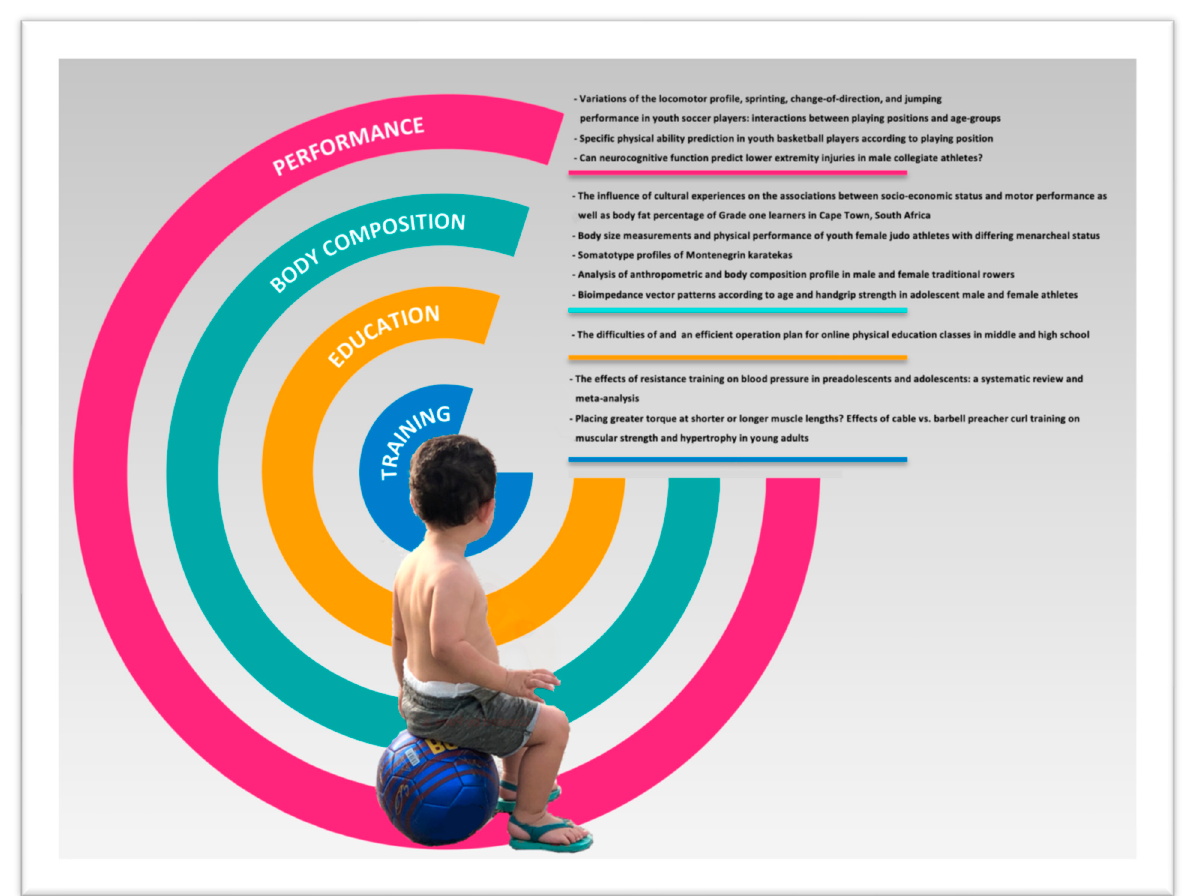
Figure 1. List of papers published in this Special Issue of IJERPH entitled Growth, Somatic Maturation, and Their Impact on Physical Health and Sports Performance [10].